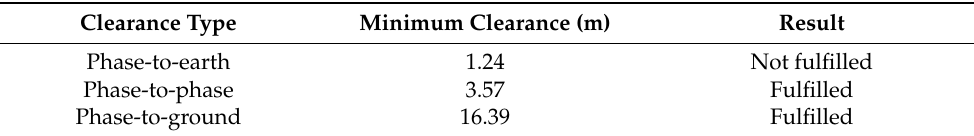
Table 5. Minimum electrical clearance of 132 kV steel lattice tower by adjusting insulator length and its creepage